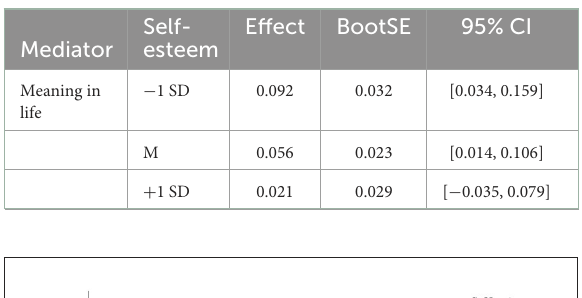
TABLE 4 Conditional indirect effect of self-esteem when meaning in life mediated between core self-evaluation and SWB.